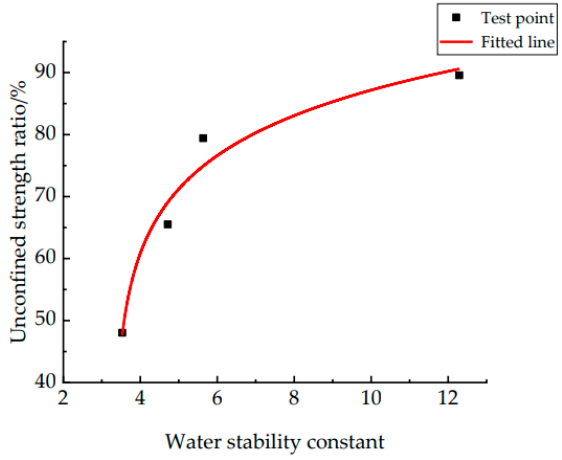
γ Figure 9. T and correlation diagram. Figure 9. T and γ correlation diagram. Fitting for the data points, and the function formula is shown by Equation